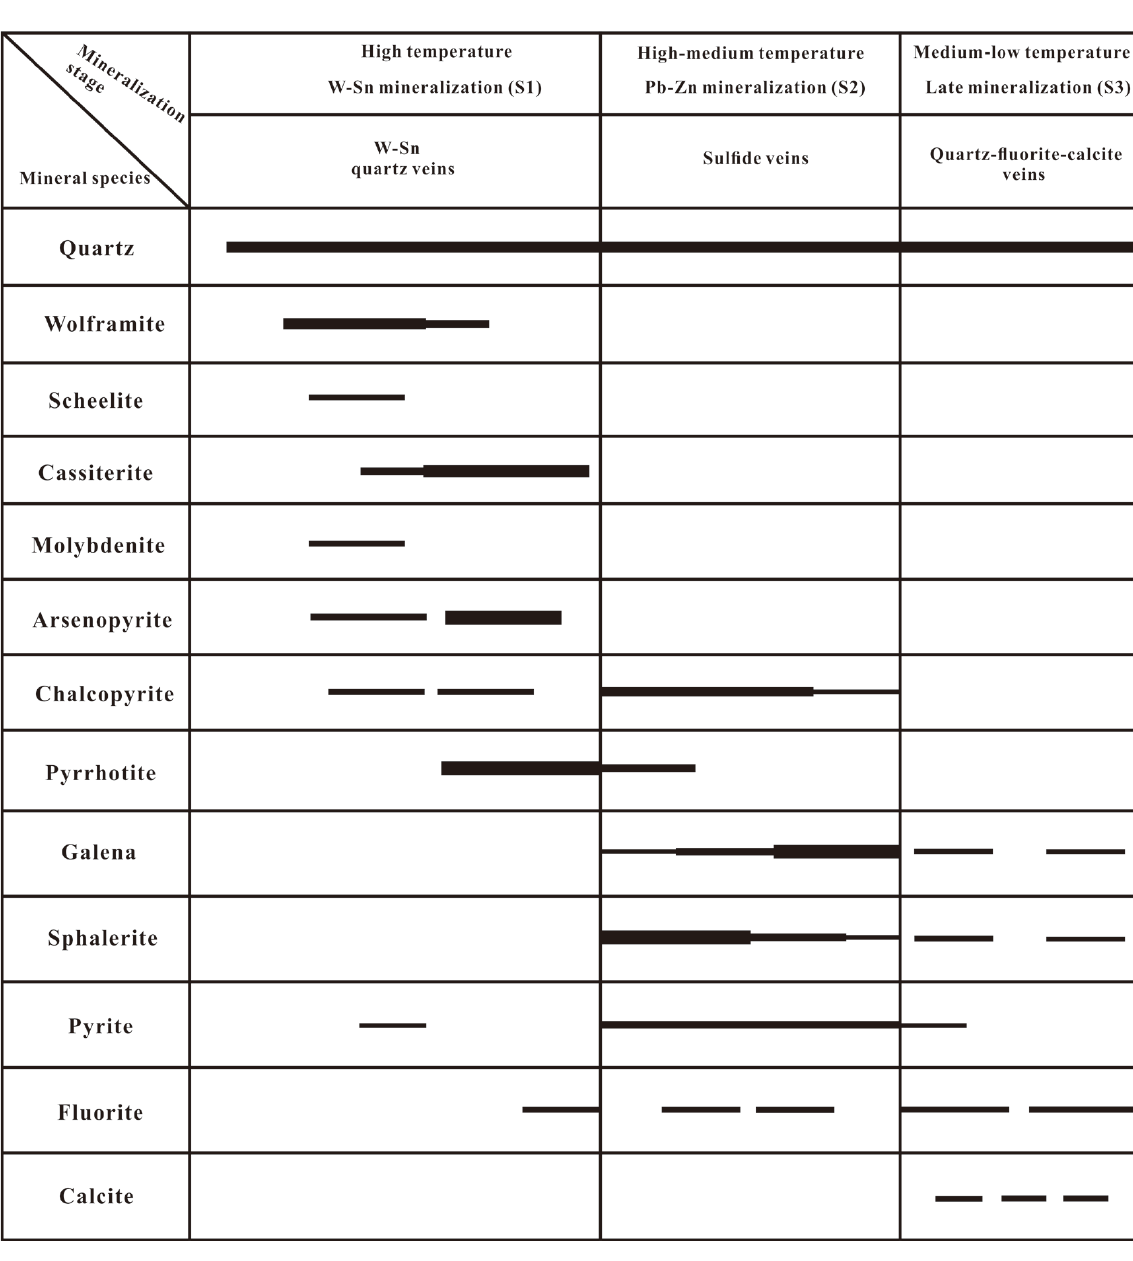
Figure 3. The mineral paragenetic sequence of the Hongqiling Sn-W polymetallic deposit.